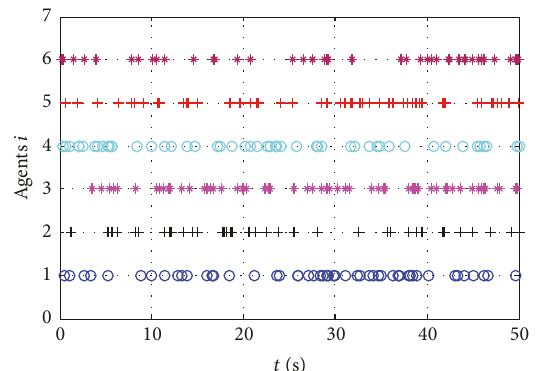
Figure 10: Events times of all agents in Case 2.